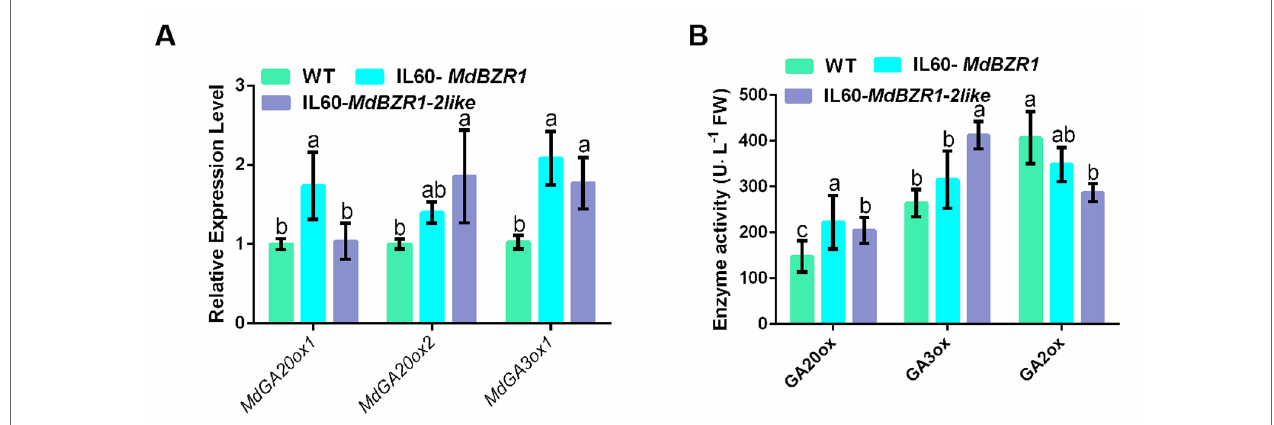
FIGURe 3 | Transient overexpression of MdBZR1 and MdBZR1-2like genes improves GA biosynthesis in apple seedings (A) The transcript levels of MdGA20ox1 , MdGA20ox2 , and MdGA3ox1 in 35S::MdBZR1 and MdBZR1-2like apple seedings. (B) The activities of GA20ox, MdGA3ox, and MdGA2ox in apple seedings. Data are shown as means ± SE of three replicates. Different letters indicate significant differences at p < 0.05.